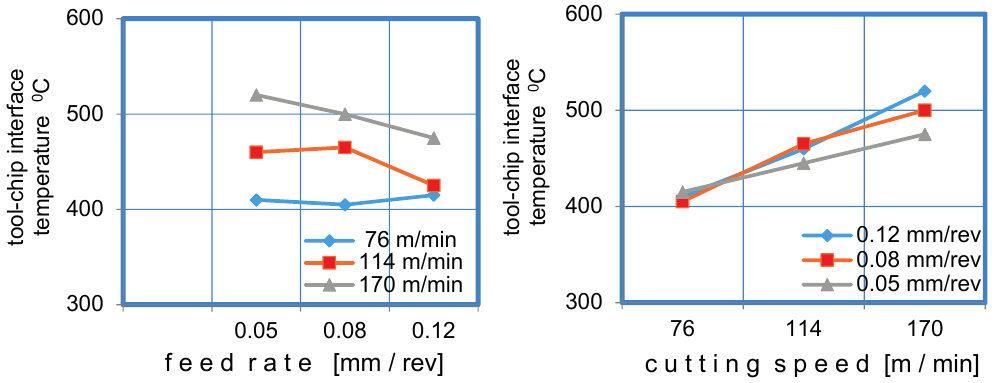
Figure 12. The influence of feed rate and cutting speed on tool-chip interface temperature. The tool-chip interface temperatures rose with the increase in cutting speed, and the chip colour became darker due to the increasing disposal rate of the chips. Significant changes in the form and the curvature of the chips were also observed. Figure 13 shows the chip forms at different tool-chip interface temperatures and different cutting speeds.